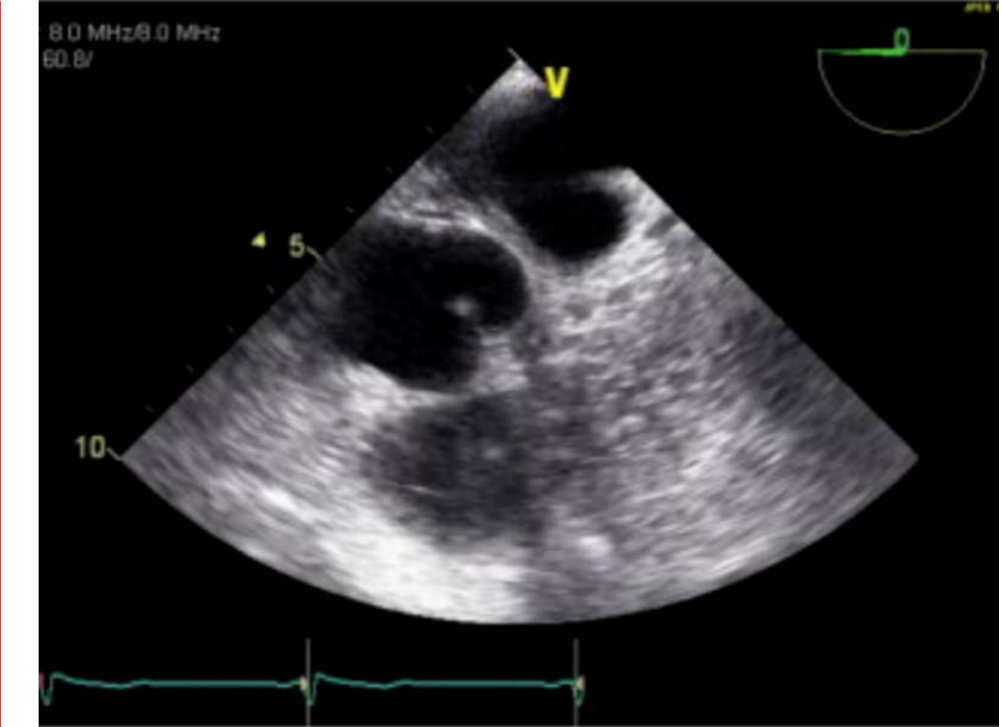
Figure 2. Transesophageal echocardiography of aortic valve showing mass on left coronary cusp, longitudinal view.